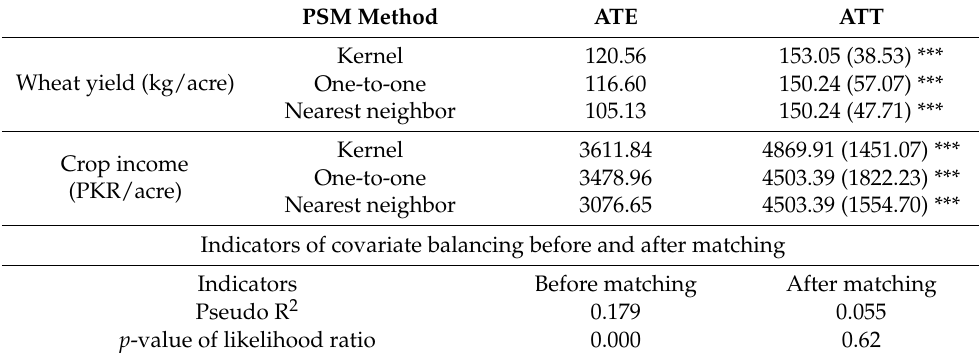
Table 8. Impact of participation in water markets on productivity and net crop income. PSM